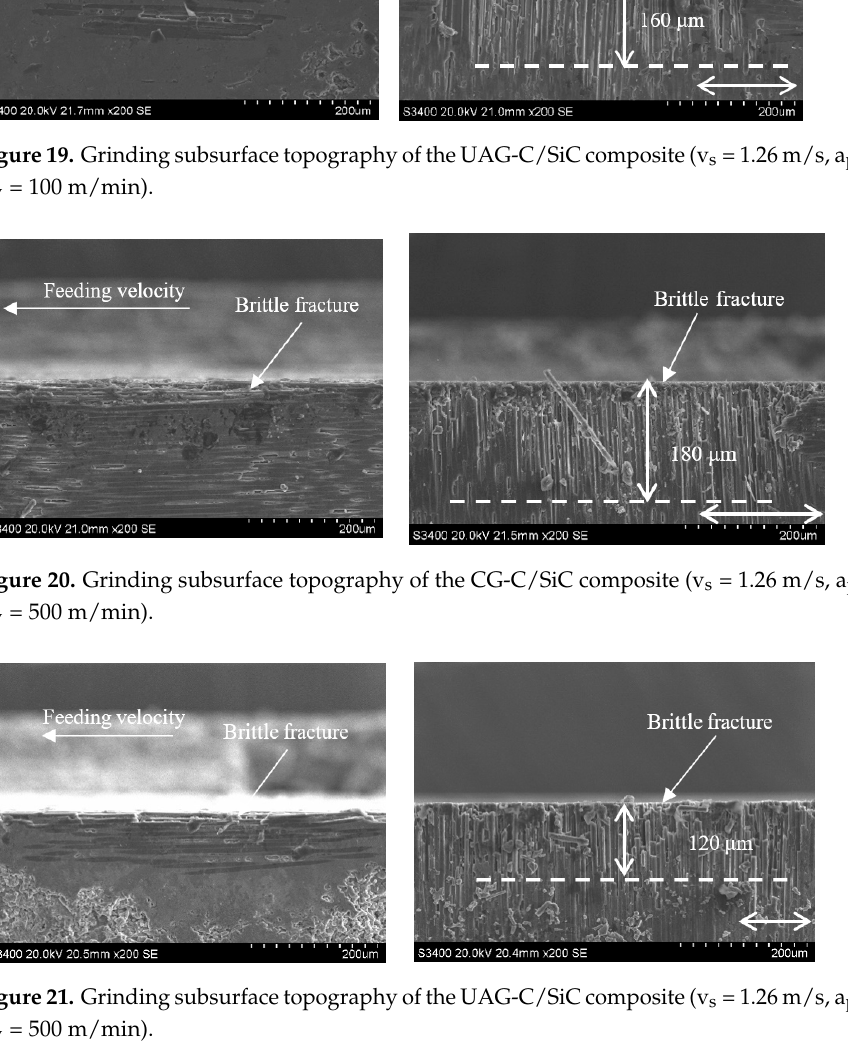
Figure 21. Grinding subsurface topography of the UAG-C/SiC composite (v s = 1.26 m/s, a p = 0.1 mm, v w = 500 m/min).